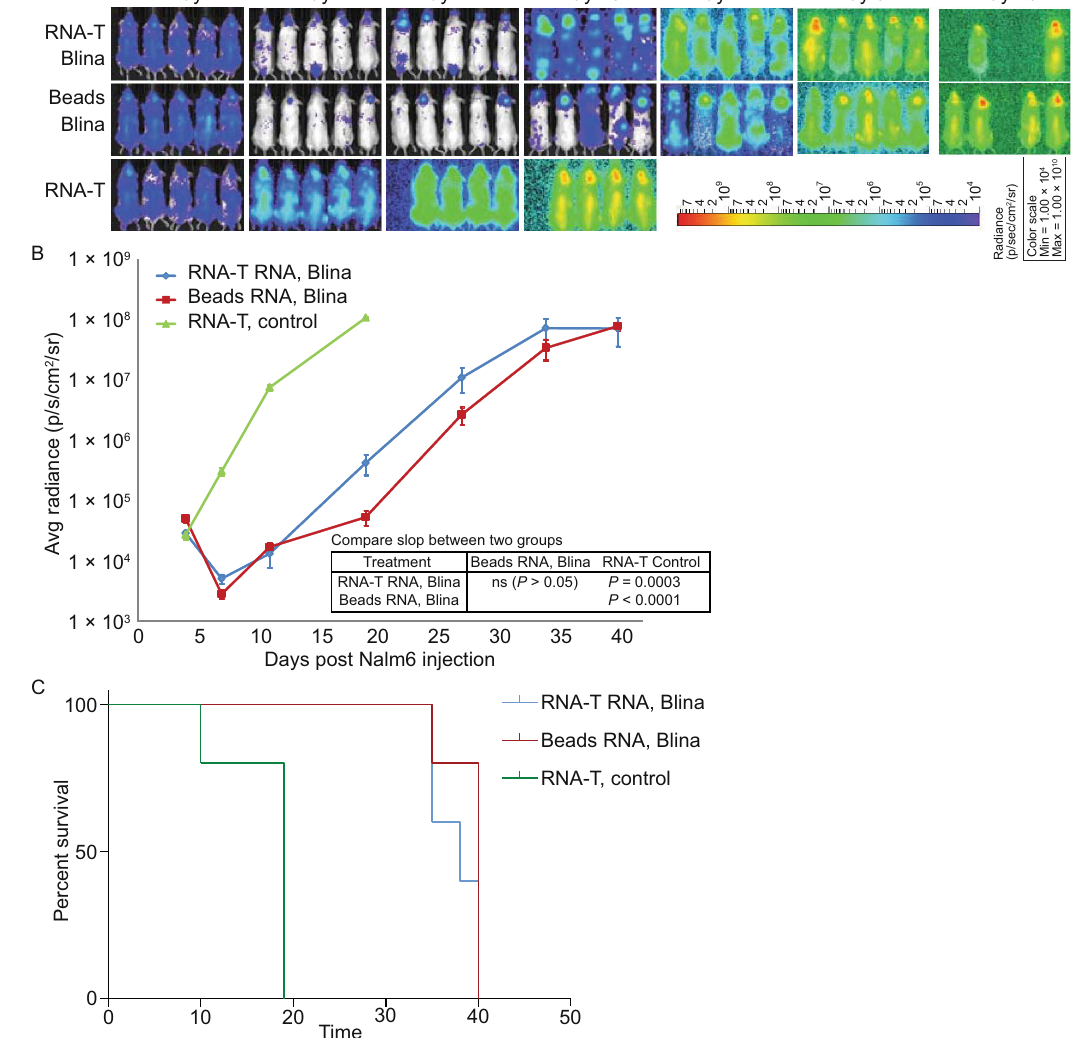
Figure 5. Treatment of Nalm6 leukemia in mice with T cells transferred with RNA encoding CD19-CD3 BiTEs. (A) Leukemia was established in NSG mice ( n = 5 per group) by intravenous (i.v.) injection with 5 × 10 6 Nalm6-CBG cells. Beginning on day 5, a single dose of 1 × 10 7 CD19-CD3 BiTE (Blina) RNA-electroporated CD3/CD28 Dynabead Tcells (Beads Blina) or RNA-Tcells (RNA- T Blina) was injected (i.v.), using non-RNA-electroporated RNA-Tcells as controls (RNA-T, control). (B) BLI was conducted at the time indicated. (C) Survival curve of the